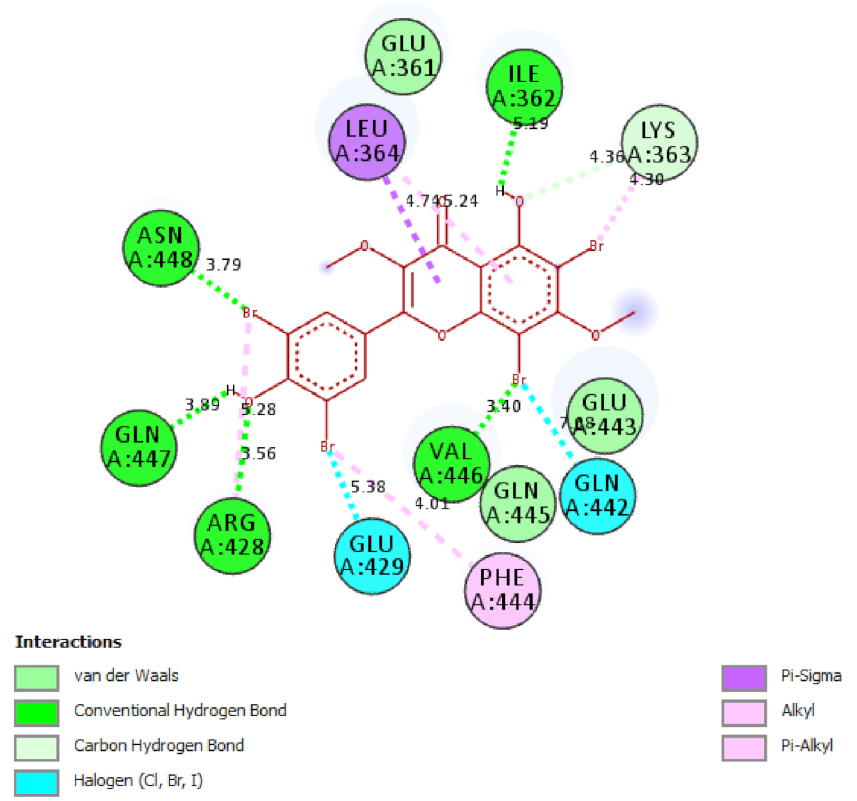
Figure 5. The most interactions between pose 11 and amino acids on receptor 4J5T were